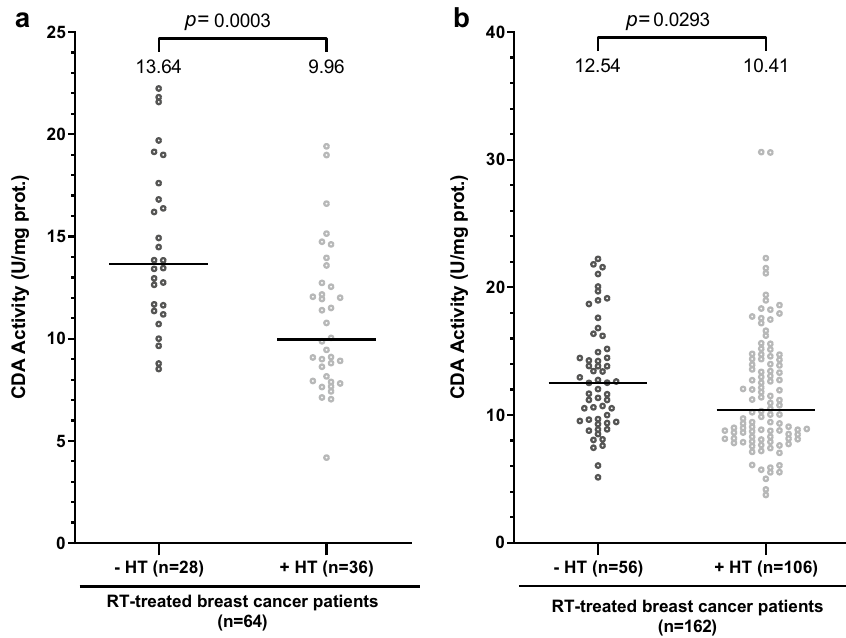
Figure 3. CDA activity in the serum of RT-treated BC patients is significantly reduced by anti-estrogen hormone therapy. ( a ) Scatter plot representation of CDA activity in enzymatic units/mg of protein in matched RT-treated BC patients not treated with HT (in black) and in RT-treated BC patients treated with HT (in gray). ( b ) Scatter plot representation of CDA activity in enzymatic units/mg of protein in RT-treated BC patients from the initial cohort not treated with HT (in black) and in RT-treated BC patients treated with HT (in gray). For each panel, medians are represented by black horizontal lines and are indicated above each distribution. n is the number of individuals. Distributions were compared in Mann–Whitney tests (see “Materials and methods” section). Values of p < 0.05 were considered statistically